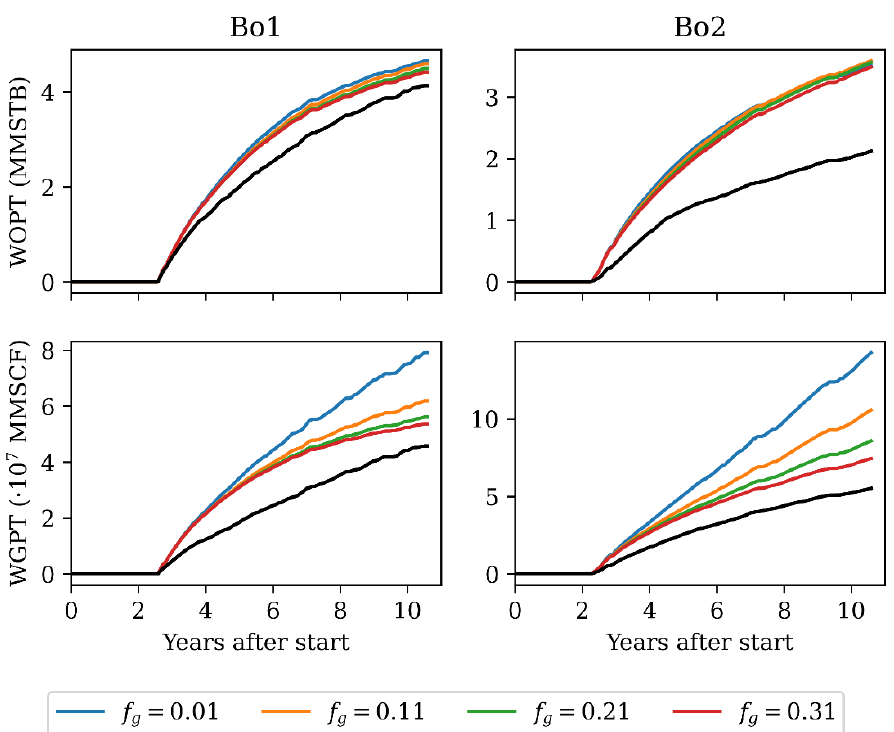
Figure 15. The production volumes for the Bo model, corresponding to the different relative permeabilities in Figure 13. Black lines denote historical data.